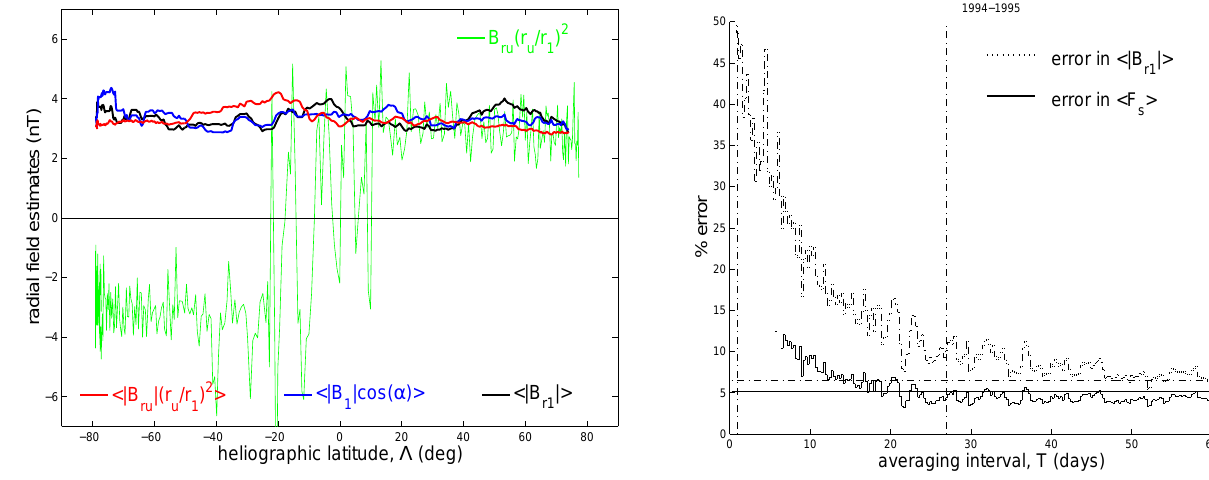
Fig. 7. Ulysses and near-Earth IMF data during the first perihelion pass as a function of the heliographic latitude of Ulysses: (green) the normalised radial field observed by Ulysses | B ru | (r u /r 1 ) 2 ; (red) 27-day means of the normalised radial field magnitude, < | B ru | (r u /r 1 ) 2 > ; (black) 27-day means of the radial field mag- nitude observed near Earth at time ( t u L< | B r 1 | > ; (blue) 27-day means of the radial field magnitude deduced from near Earth mea- surements at time ( t u L ) from the magnitude of the field B 1 with the average garden hose angle α , <B 1 cos (α)> .